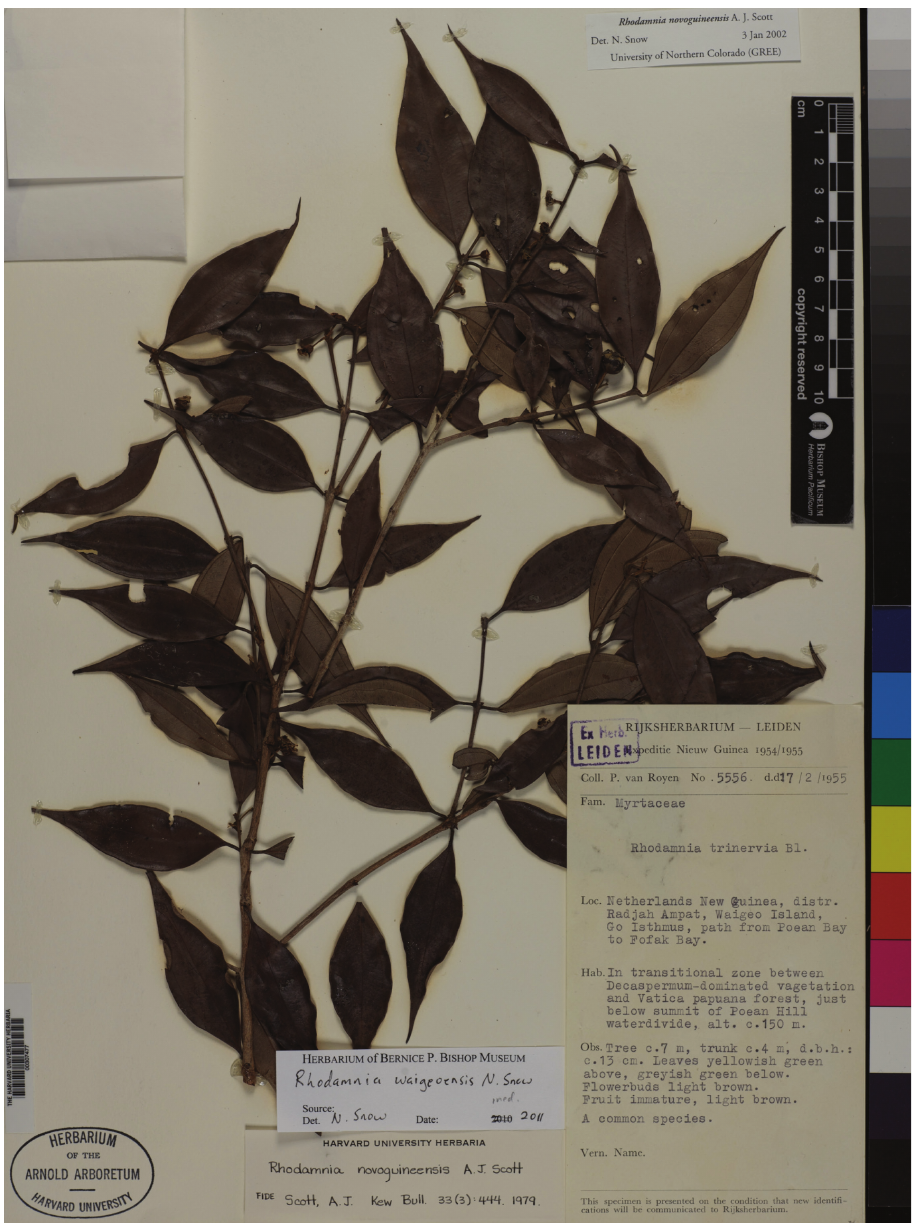
Figure 6. Rhodamnia waigeoensis N. Snow. Photo of the the holotype at A ( P. van Royen 5556 ) mostly yellowish or somewhat ferrugineous but becoming more whitish with age. Leaves opposite, evenly distributed along branchlets, discolorous, glossy above and below, the nacreous sheen below imparted by the dense, tightly appressed green- ish-white indumentum. Colleters absent. Petioles 5–6.5 mm long, somewhat